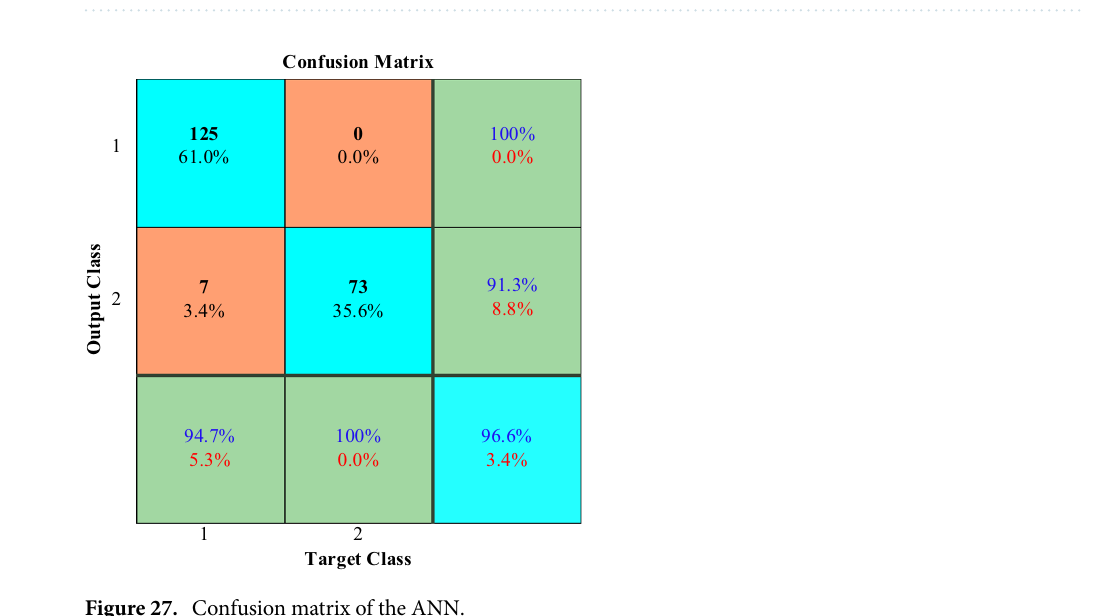
Figure 27. Confusion matrix of the ANN.